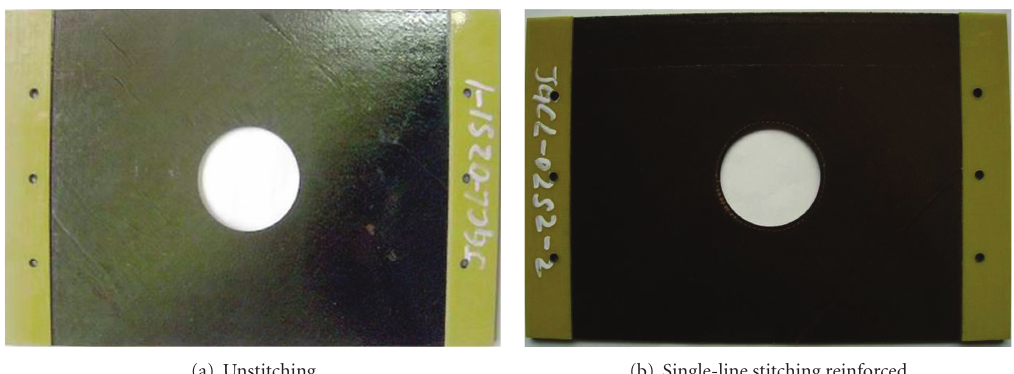
Figure 1: The specimens with and without stitching.